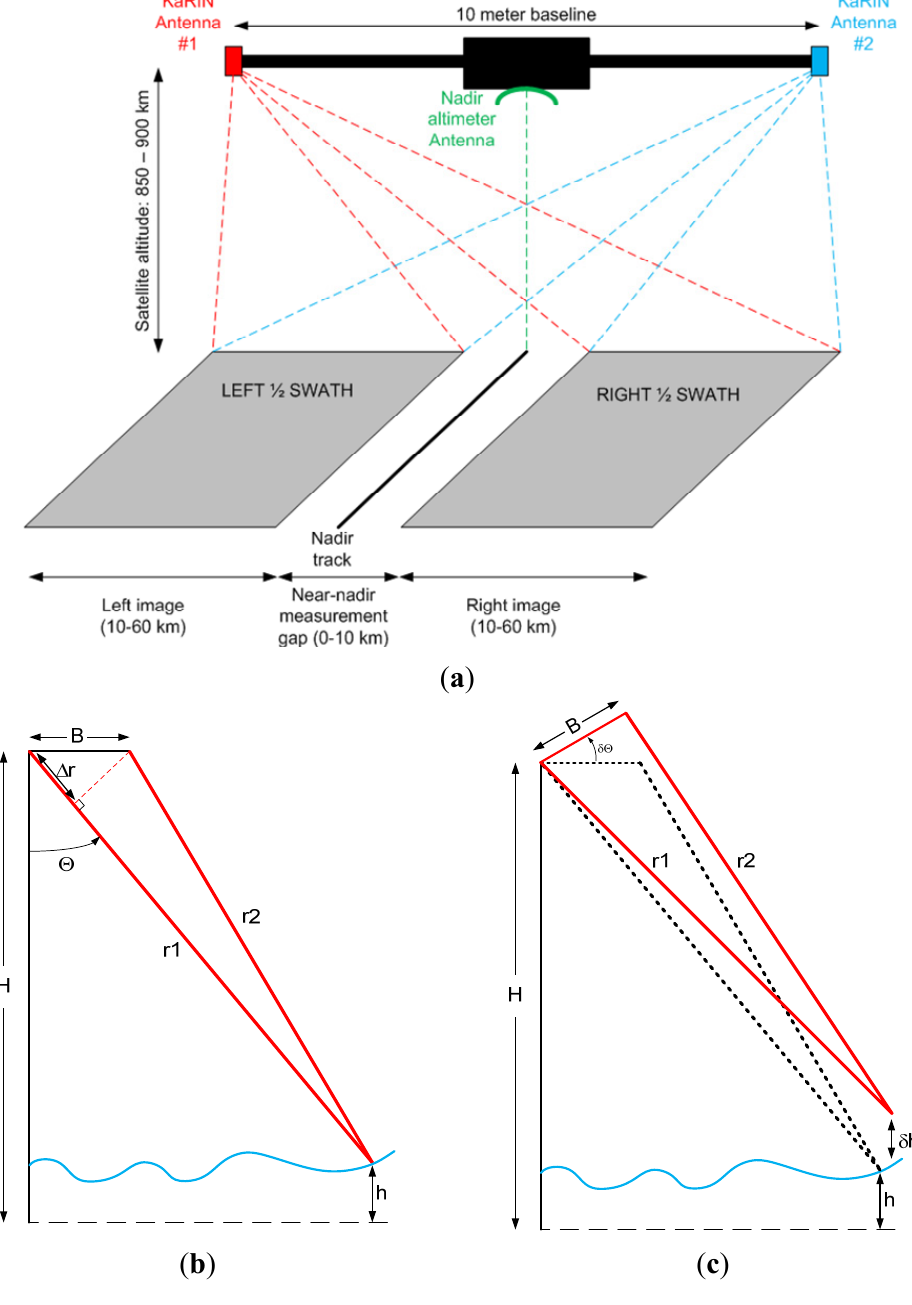
Figure 1. Conceptual overview of KaRIN, SWOT’s proposed Ka-band radar interferometer ( a ). KaRIN’s interferometric measurement concept ( b ) and consequence of a non-zero roll angle ( c